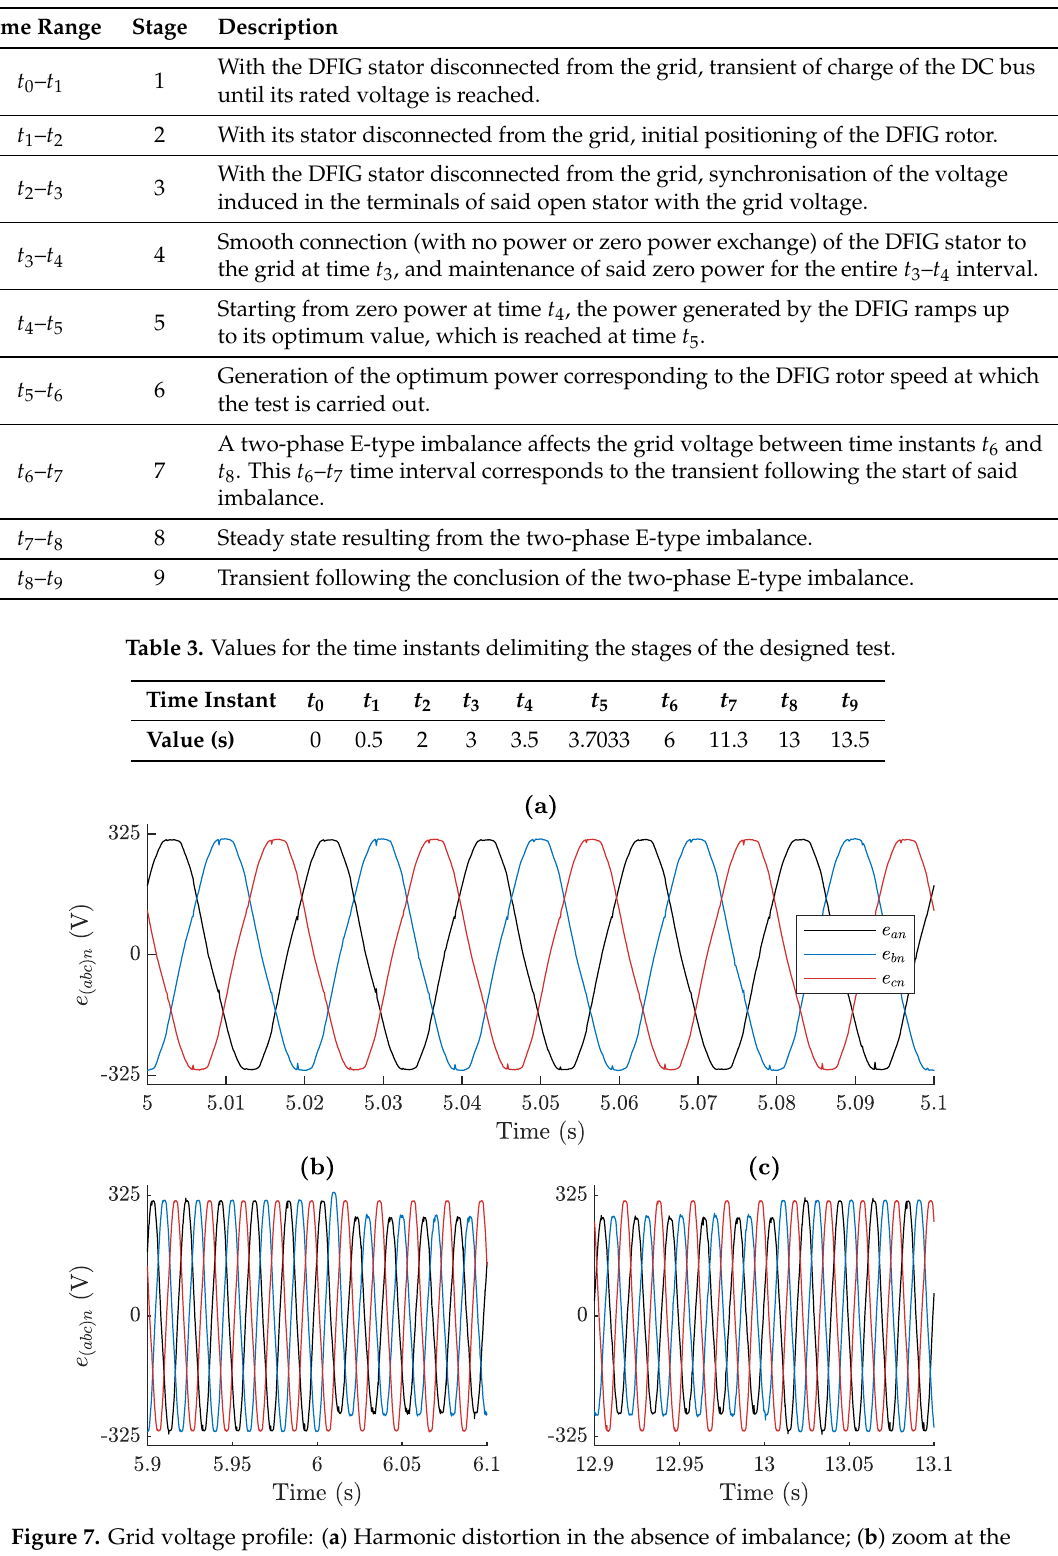
Table 2. Stages of the designed test.